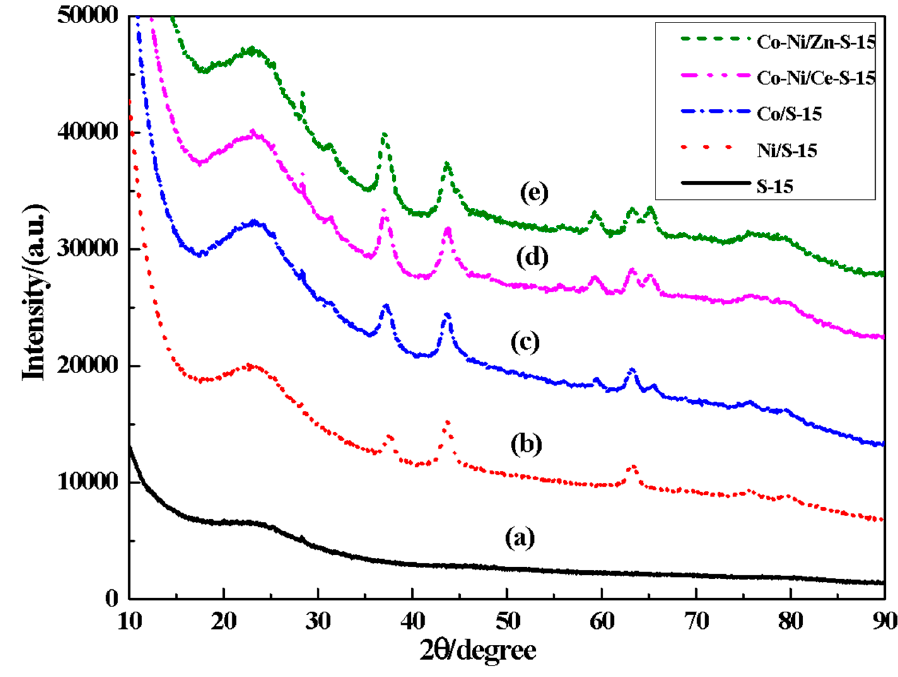
Figure 1. XRD patterns of calcined samples: ( a ) S15, ( b ) 5% Ni / S15, ( c ) 5% Co / S15, ( d ) 2.5% Ni + 2.5% Co / Ce + S15, ( e ) 2.5% Ni + 2.5% Co / Zn + S15.